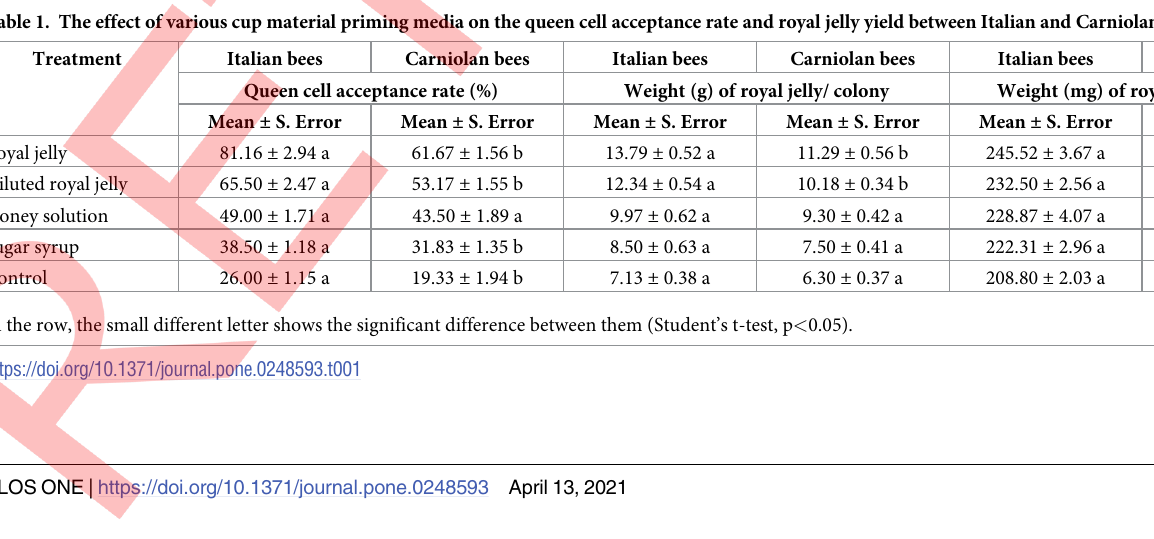
The queen cell acceptance rate significantly differed between Italian colonies with various priming material in plastic cell cups (F = 116.465, P = 0.001). Similarly, queen cell acceptance rate was significantly different within Carniolan bee colonies (F = 100.526, P = 0.001). In Ital- ian bee colonies, the maximum queen cell acceptance rate was found in RJ primed plastic cup (81.16 ± 2.94%) compared to the other priming media. The percentage of less queen cell accep- tance rate was (26.00 ± 1.15%) recorded for control group. In Carniolan bee colonies, the max- imum queen cell acceptance rate was 61.67 ± 1.56% in RJ primed cups compared to control (19.33 ± 1.94%) (Table 1). The RJ production significantly differed in Italian bee colonies with various type of primed cups (F = 25.208, P = 0.001). In Italian bee colonies, the RJ production was 13.79 ± 0.52 g in